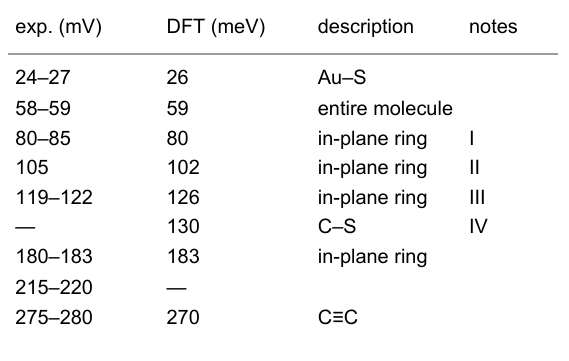
Table 1: Experimental IETS peaks energies (junction 1) and theoreti- cal vibrational